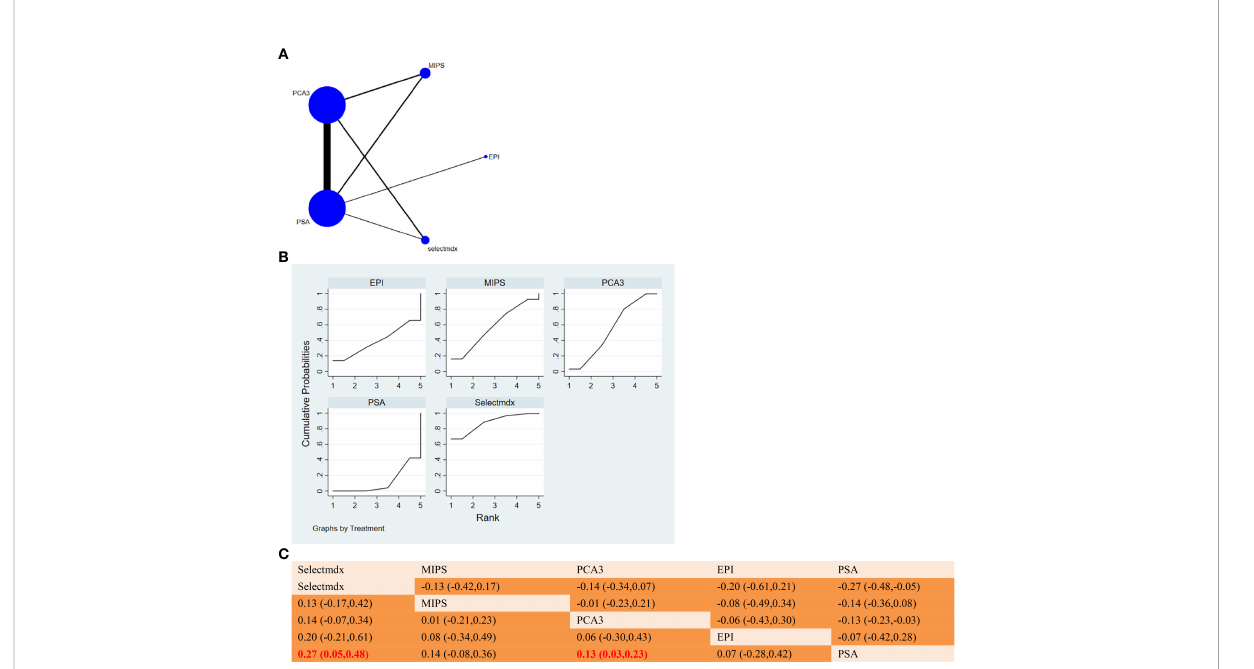
FIGURE 5 (A) NMA fi gure for PPV. (B) SUCRA plot for PPV. (C) League table on PPV.